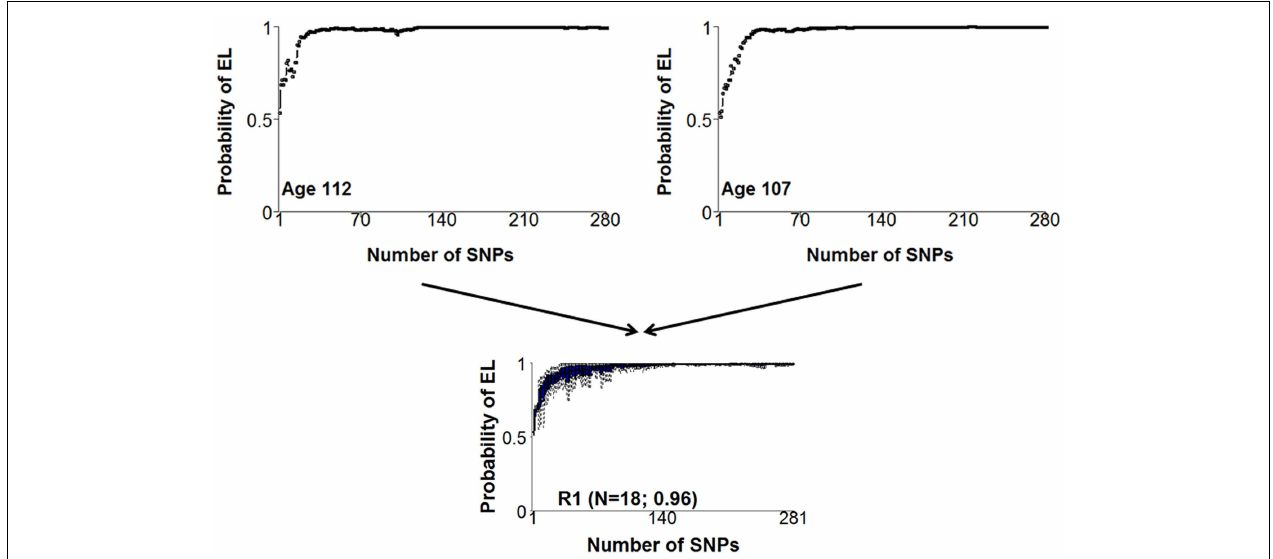
varying combinations of genotypes of the 281 SNPs that we found associated with exceptional longevity.The two plots are not exactly the same, meaning that the two subjects have some different alleles of the 281 SNPs. However, the similar pattern of risk means that they essentially have the same genetic basis for exceptional longevity and were assigned to the same cluster displayed in the bottom